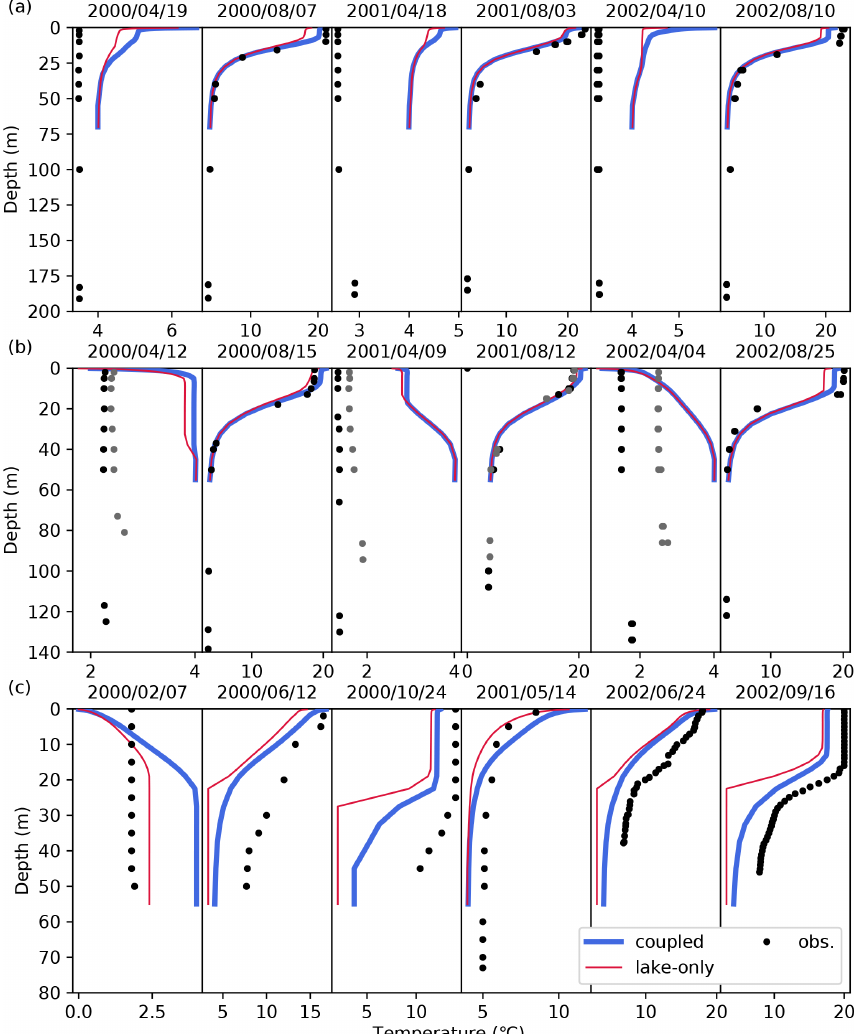
Figure 12. Comparison between vertical water temperature profiles of simulations and observations for (a) Lake Ontario, (b) Lake Huron, and (c) Lake